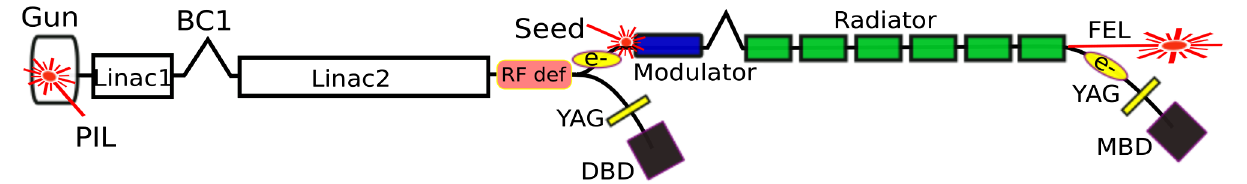
FIG. 1 (color online). FERMI layout includes the gun with the photoinjector laser (PIL), the linacs (linac 1 and 2), the bunch compressor (BC1), the undulators where the FEL is produced, and the spectrometer lines (DBD and MBD) for the beam energy characterization. A transverse rf deflector (RF def) installed before DBD allows one to measure the electron-beam longitudinal phase space in this location, the deflector is off during standard operations of the linac and during